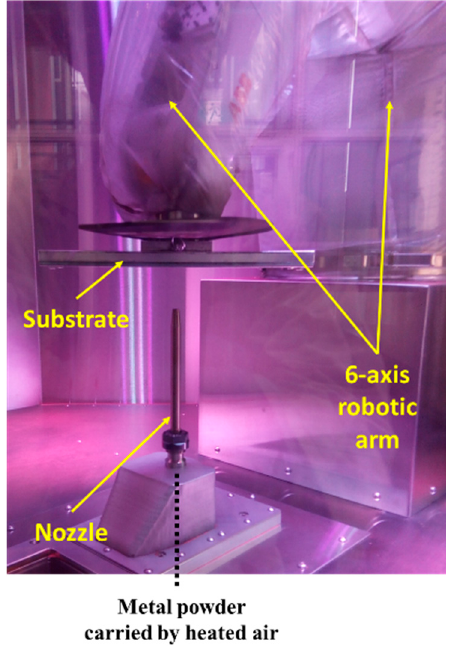
Figure 2. Cold spray coating machine used in this study consisting of a stationary nozzle through which copper powder was sprayed onto stainless steel or aluminum substrates, attached to the end effector of a 6 ‐ axis robotic arm.